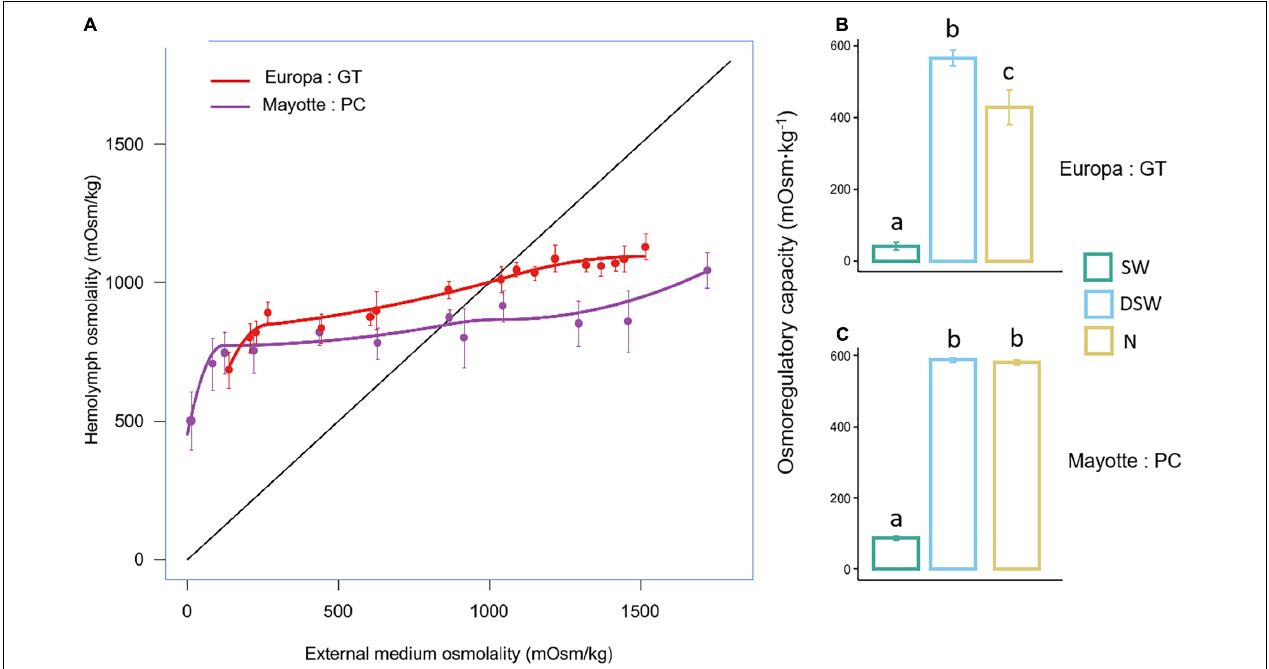
FIGURE 3 | (A) Variations in hemolymph osmolality in relation to the salinity of the external medium of GT and PC. (B,C) Osmolaregulatory capacity of GT and PC, respectively, after 96 h exposition to seawater (SW), diluted seawater (DSW) and 10 mg.L - 1 ammonia-N (N). Values are means ± SEM ( N = 7–8 per treatment). Different letters represent statistically significant differences between treatments at p < 0.05 obtained from a one-way ANOVA followed by Tukey post hoc